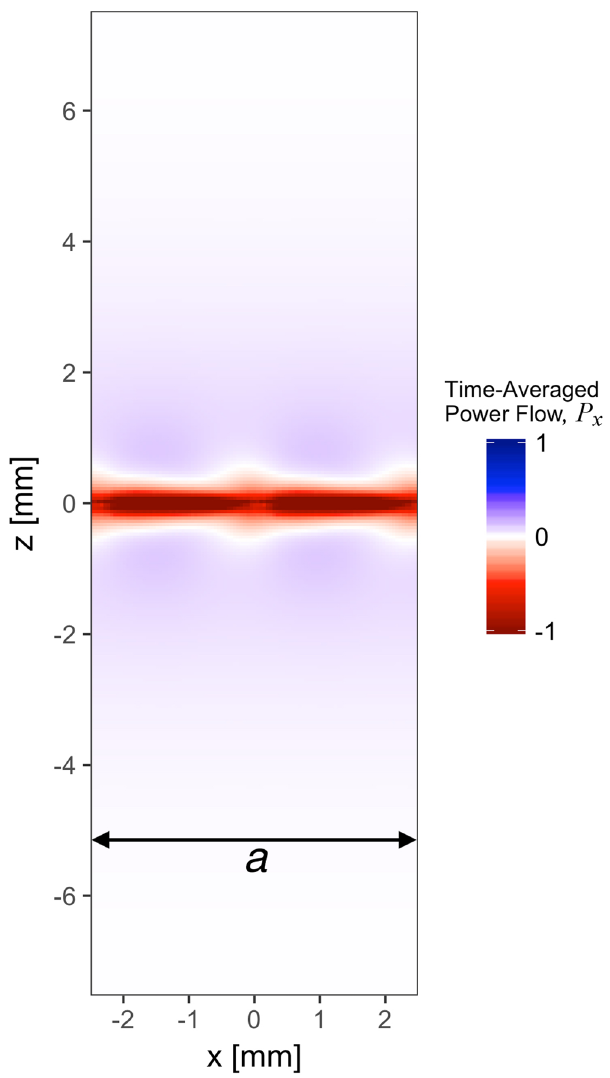
Figure 4. Simulated x-component of the time-averaged power flow (arbitrary scale), integrated in the y direction (out-of-plane), for the third eigenmode ( f = 9.17 GHz) with in-plane wavevector of ( k x , k y ) = (350, 0) m − 1 . This corresponds to the blue square on Fig. 2, where the group velocity is zero. The sample lies in the z = 0 plane and the x -axis of the figure spans one unit